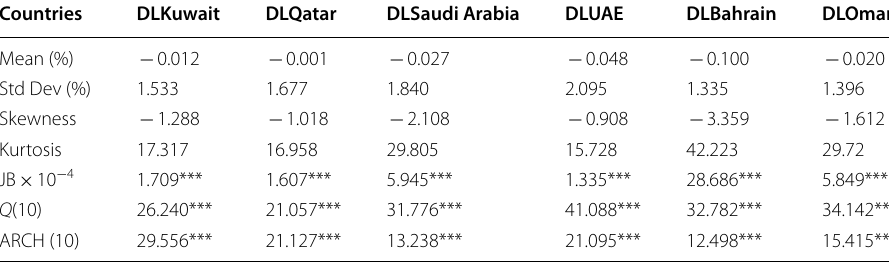
JB is the statistic of Jarque and Bera test for normality, is the statistic of Ljung-Box test for serial correlation for order, and ARCH is the statistic of ARCH test for heteroskedasticity *** denote significance at the 1% levels